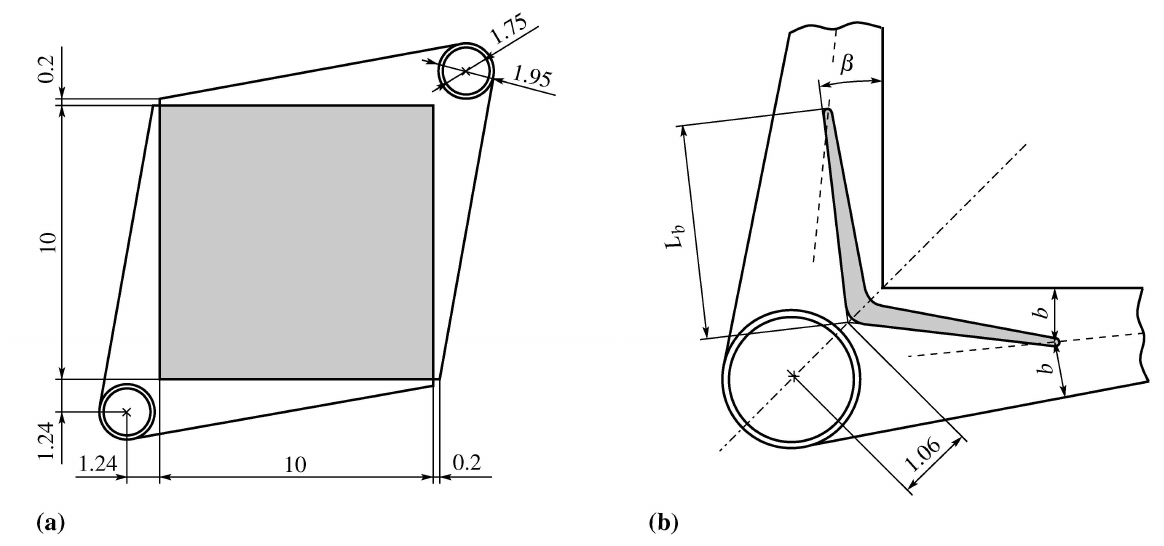
Figure 3. Plan view and dimensions in millimeters of the computational domain: ( a ) basic geometry; ( b ) angled baffle position in the inlet